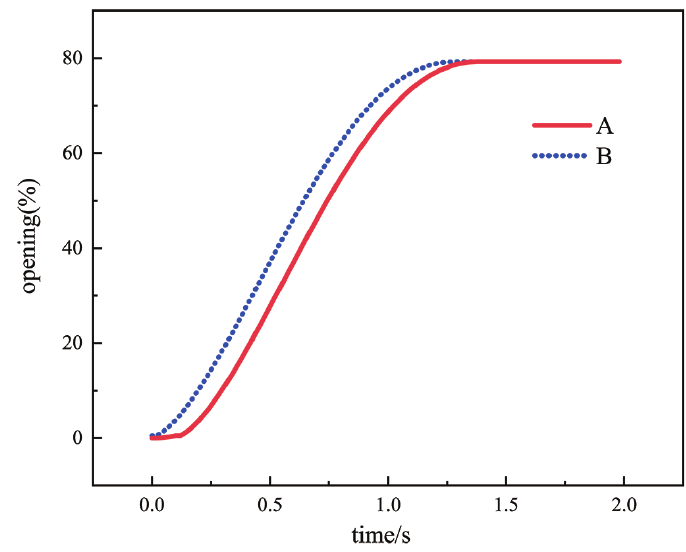
Figure 8. Valve position response under different frictional forces.